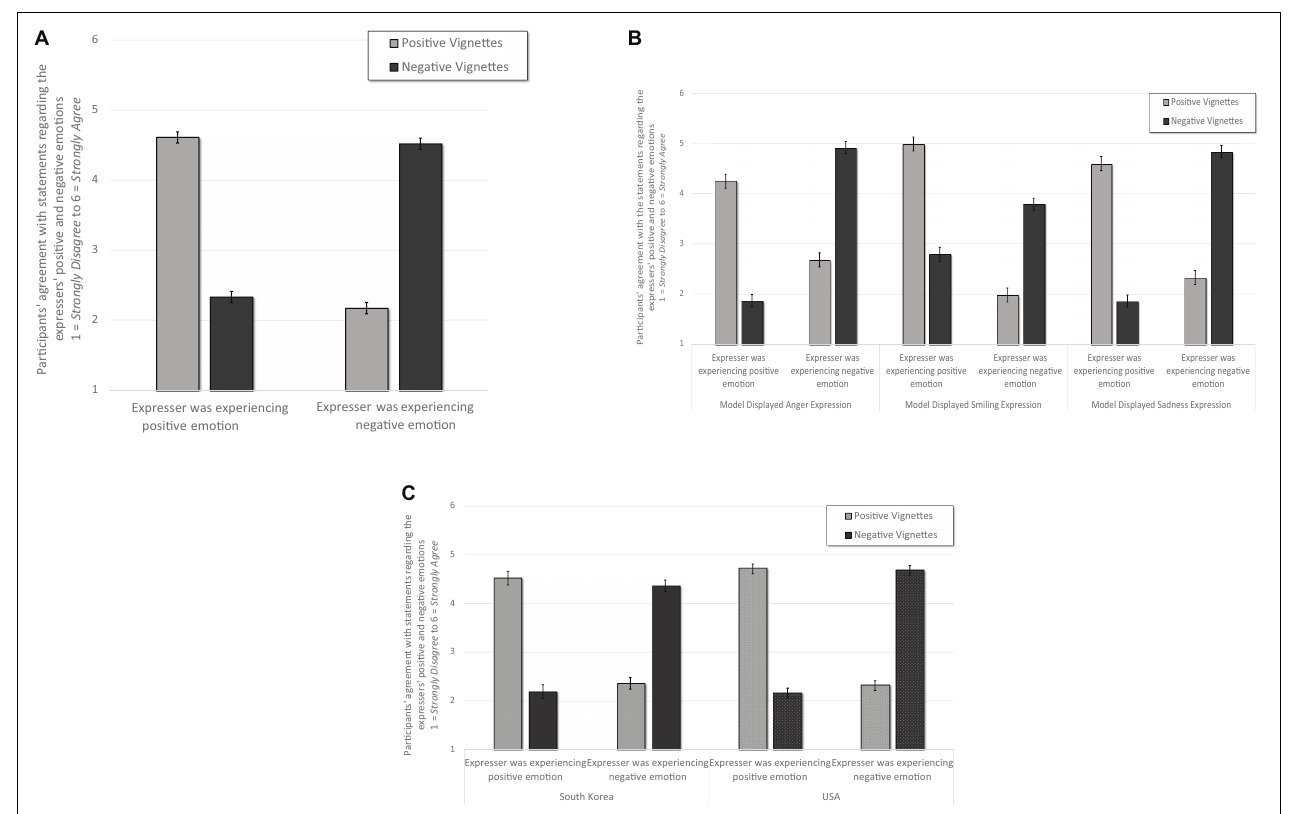
FIGURE 4 | Overall, positive contexts were deemed to produce positive- not negative emotions, and negative contexts were deemed to produce negative – not positive emotions, as in every case means and deviations clearly fell within agreement and disagreement categories. Panel (A) illustrates that participants’ inferences about the valence of experience for the expresser was chiefly determined by the positive or negative framing of the context. Panel (B) shows a moderation by expression, which was chiefly driven by smiles seen as representing lower negative and higher positive emotions in negative situations. Panel (C) illustrates that American participants rated higher positive emotion in positive vignettes, and higher negative emotion in negative vignettes than did South Korean participants. Error bars indicate ± 2 standard errors.